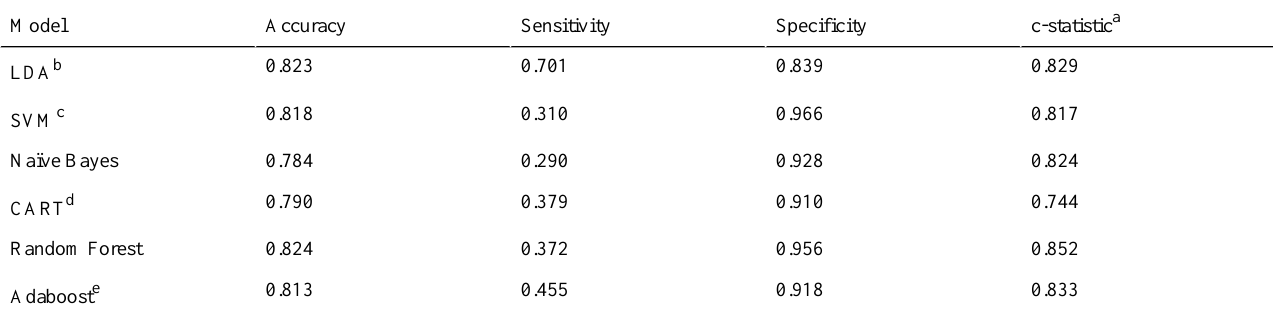
Table 5. Performance of different machine-learning models on predicting mortality of patients with noncancer end-stage liver diseases using the validation dataset.